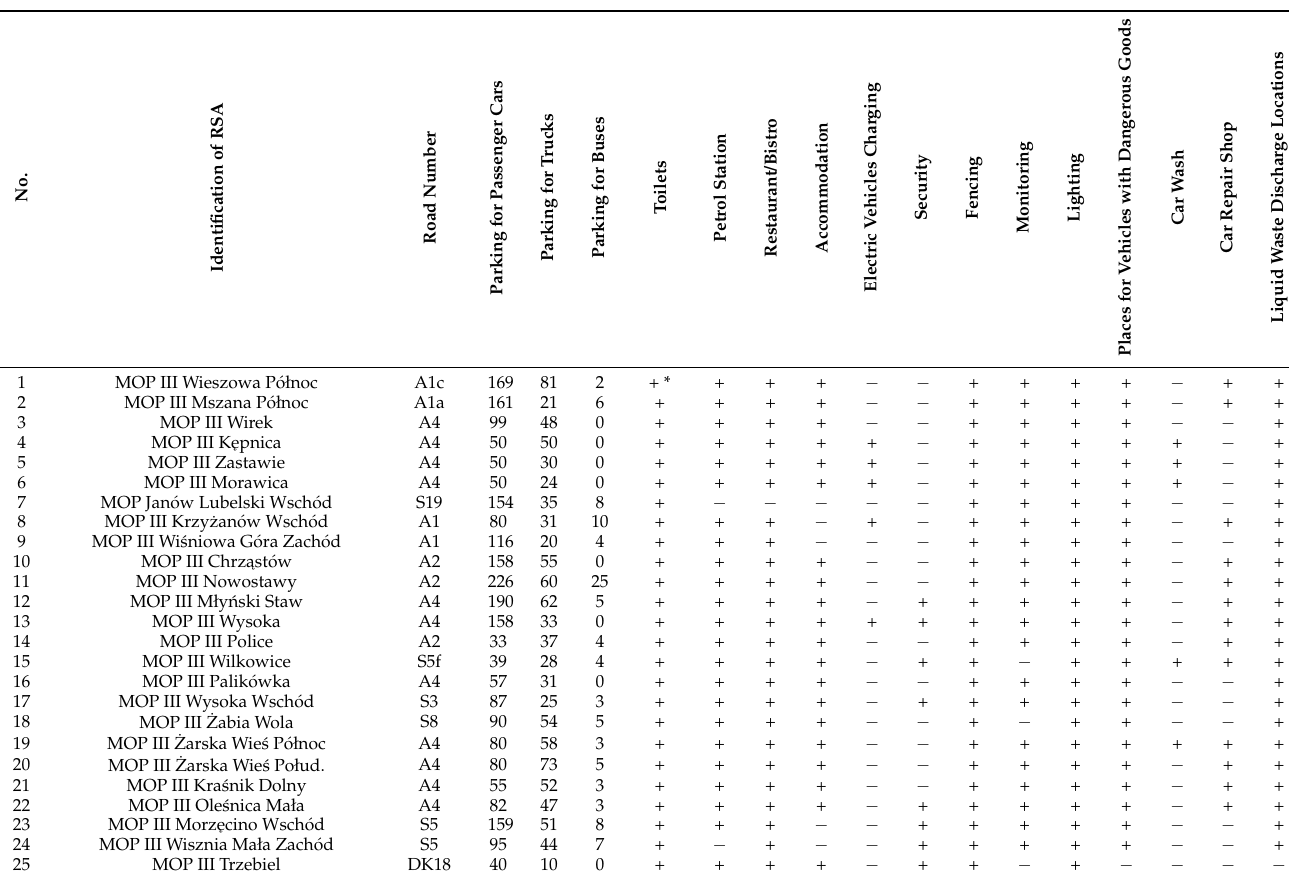
Table 5. Infrastructure of class III RSAs in Poland (own elaboration based on